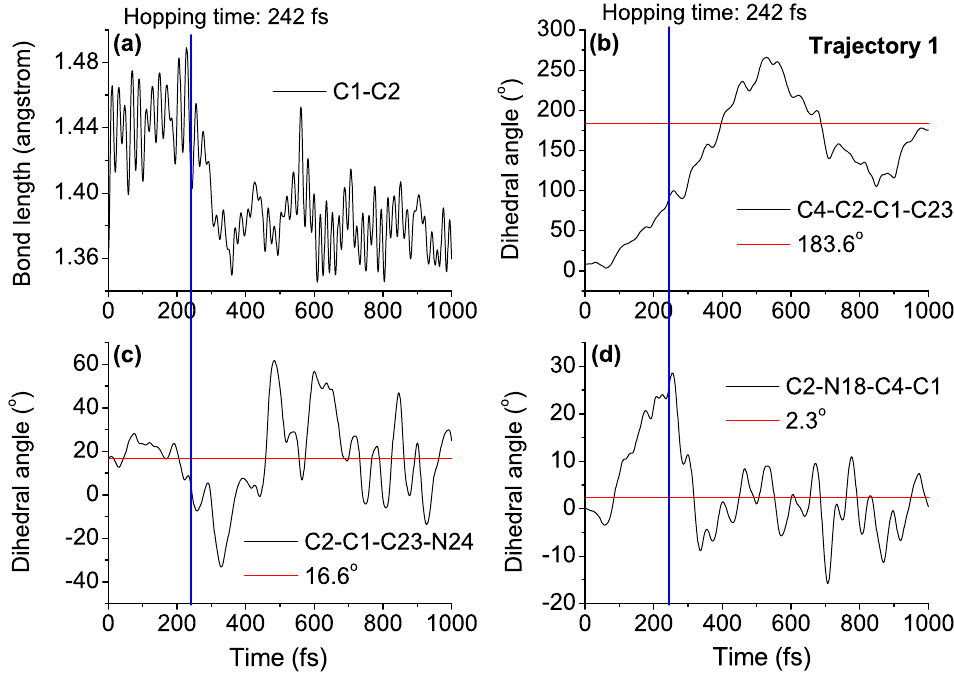
Figure 6. Time dependence of ( a ) central bond length C1-C2; ( b ) central dihedral angle C4-C2-C1-C23; ( c ) side dihedral angle C2-C1-C23-N24; and ( d ) pyramid dihedral angle C2-N18-C4-C1 in a repre- sentative trajectory (called trajectory 1) of EP → ZP photoisomerization process. The S 1 → S 0 hopping time (blue line) and corresponding geometrical parameters of reaction product ZP isomer (red lines) are also shown in the